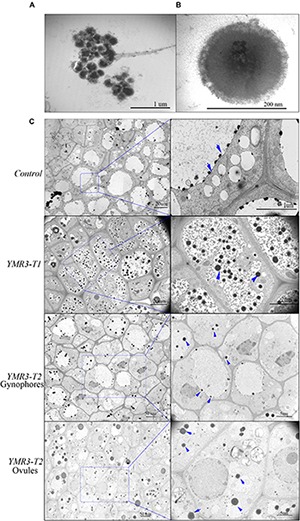
Distribution of endophytic bacteria during peanut development. (A) Colonies or (B) individual cells of P.g.YMR3 observed by transmission electron microscopy (TEM). (C) Endophytic bacteria in peanut root tips. “Control” indicates seedlings grown normally in the greenhouse without treatment with P.g.YMR3 bacteria, while “YMR3-T” represents peanut progeny seedlings had been treated with P.g.YMR3 bacteria. After cultivation for about 45 days, the root tips, gynophores, and ovules were harvested and imaged by TEM. The blue arrows indicate possible individual bacterial cells.